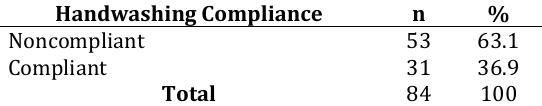
Table 2. Distribution of Respondents’ Handwashing Handwashing Compliance